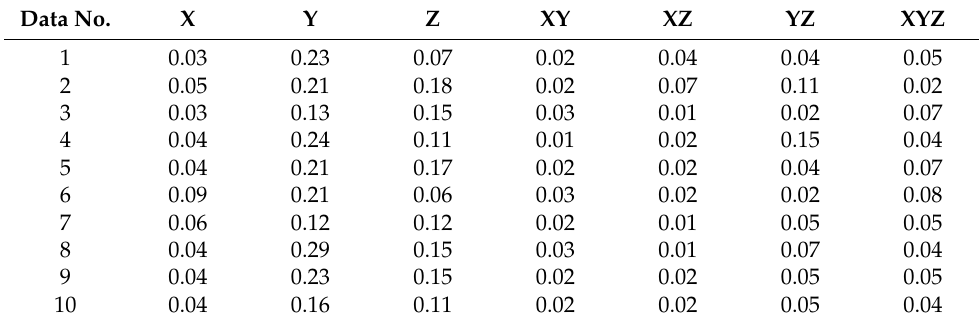
Table 10. CNN summary of ‘loss on test data’. Data